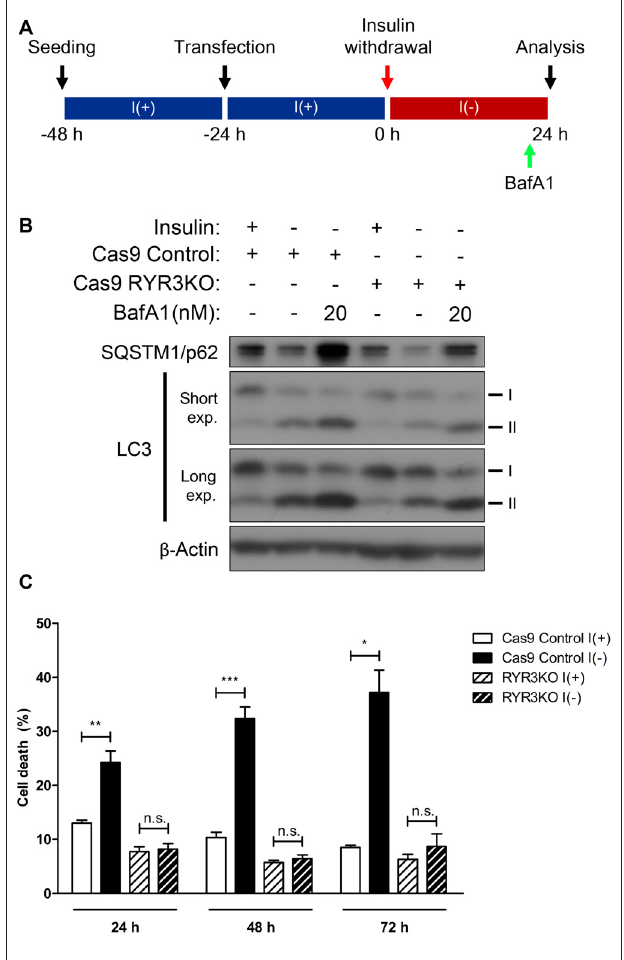
FIGURE 6 | Genetic suppression of RyR3 diminishes autophagic flux in I( − ) HCN cells. (A–C) Effect of CRIPR/Cas9-induced RYR3 knockout on ACD in I( − ) HCN cells. (A) An experimental scheme for inhibition of autophagic flux by BafA1 treatment. (B) Characterization of autophagic flux by immunoblotting of LC3 and SQSTM1/p62 in RYR3KO I( − ) HCN cells treated with BafA1. Cells were treated with BafA1 for 2 h at given concentration before harvest. (C) Rate of cell death in RYR3KO HCN cells under I(+) and I( − ) conditions for 24 h, 48 h, and 72 h; each experiment performed in triplicate per experiment ( n = 4). The bars represent the mean ± SEM; ∗ p < 0.05, ∗∗ p < 0.01, ∗∗∗ p < 0.001; n.s.,